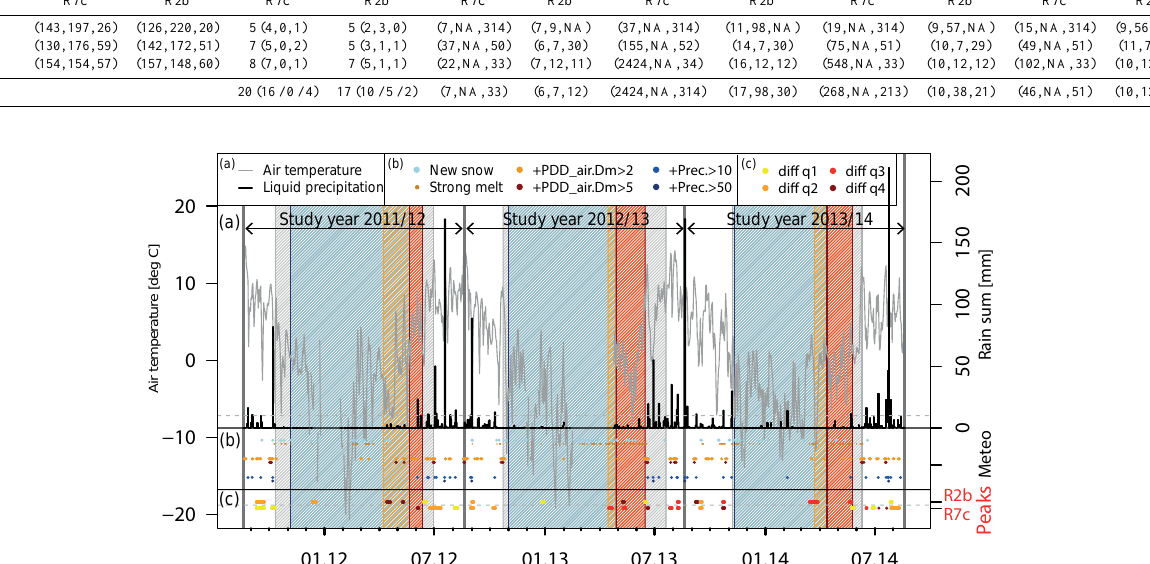
Figure 7. Comparison of velocity peaks at R2b and R7c to meteorological factors. Panel (a) : air temperature and liquid precipitation, both measured at the weather station within the study. Vertical grey lines separate the 3 different years of observation (2011/12, 2012/13, 2013/14). Panel (b) : in the middle of the plots, the coloured dots refer to the occurrence of exceptional values of meteorological factors: new snow – on this day fresh snow was clearly visible on webcam images; strong melt – on this day strong melt was clearly visible on webcam images; ◦ C; +PDD + PDD ≥ 2 – the difference of PDD ≥ 5 – air .Dm air on that day compared to the monthly mean of PDD air was above 2 air .Dm the difference of PDD air on that day compared to the monthly mean of PDD air was above 5 ◦ C; + Prec ≥ 10 – the daily amount of liquid precipitation was 10mm or more; + Prec ≥ 50 – the daily amount of liquid precipitation was 50mm or more. Panel (c) : occurrence of velocity peaks for R2b (upper bars) and R7c (lower bars). The colours of the peak periods refer to the strength of the peaks (given as the 25, 50, and 75% quantile of diff p